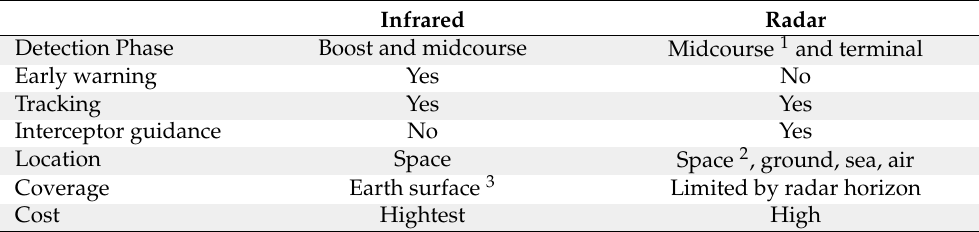
Table 5. Comparison of the two main types of sensor for long range missile